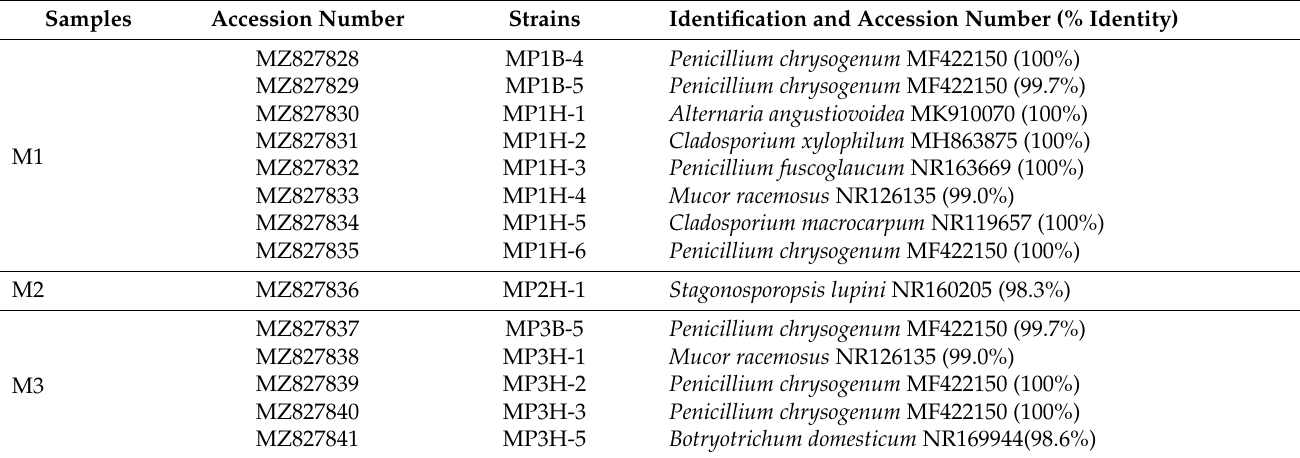
Table 4. Identification of fungi isolated from Sal ó n de Reinos